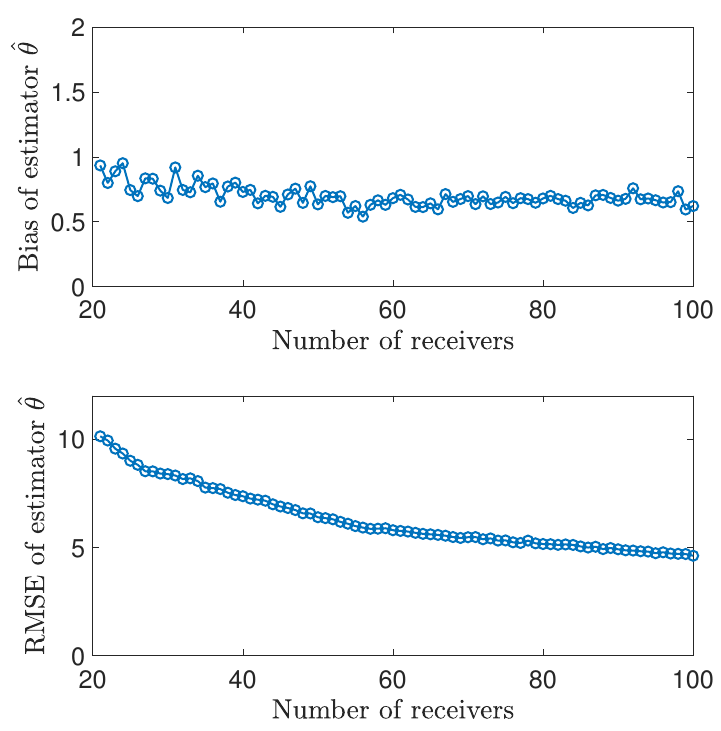
Figure 8. Normalized running time for locating multiple disjoint targets.